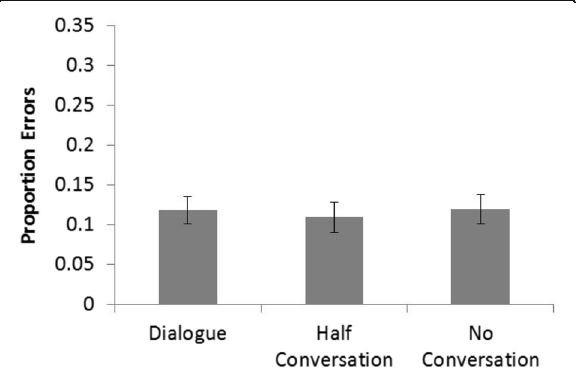
Fig. 11 The proportion of errors for each condition in experiment 4. Error bars represent the standard